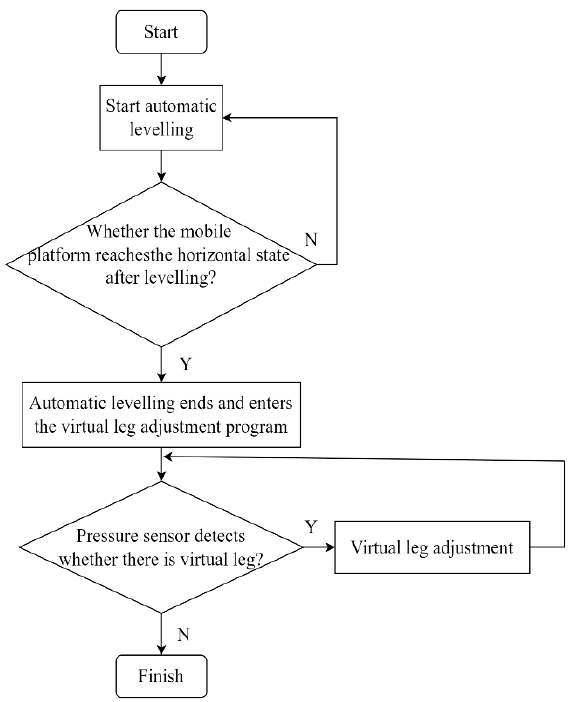
Figure 7. Virtual leg control flow chart. Table 1. Switch signal input.